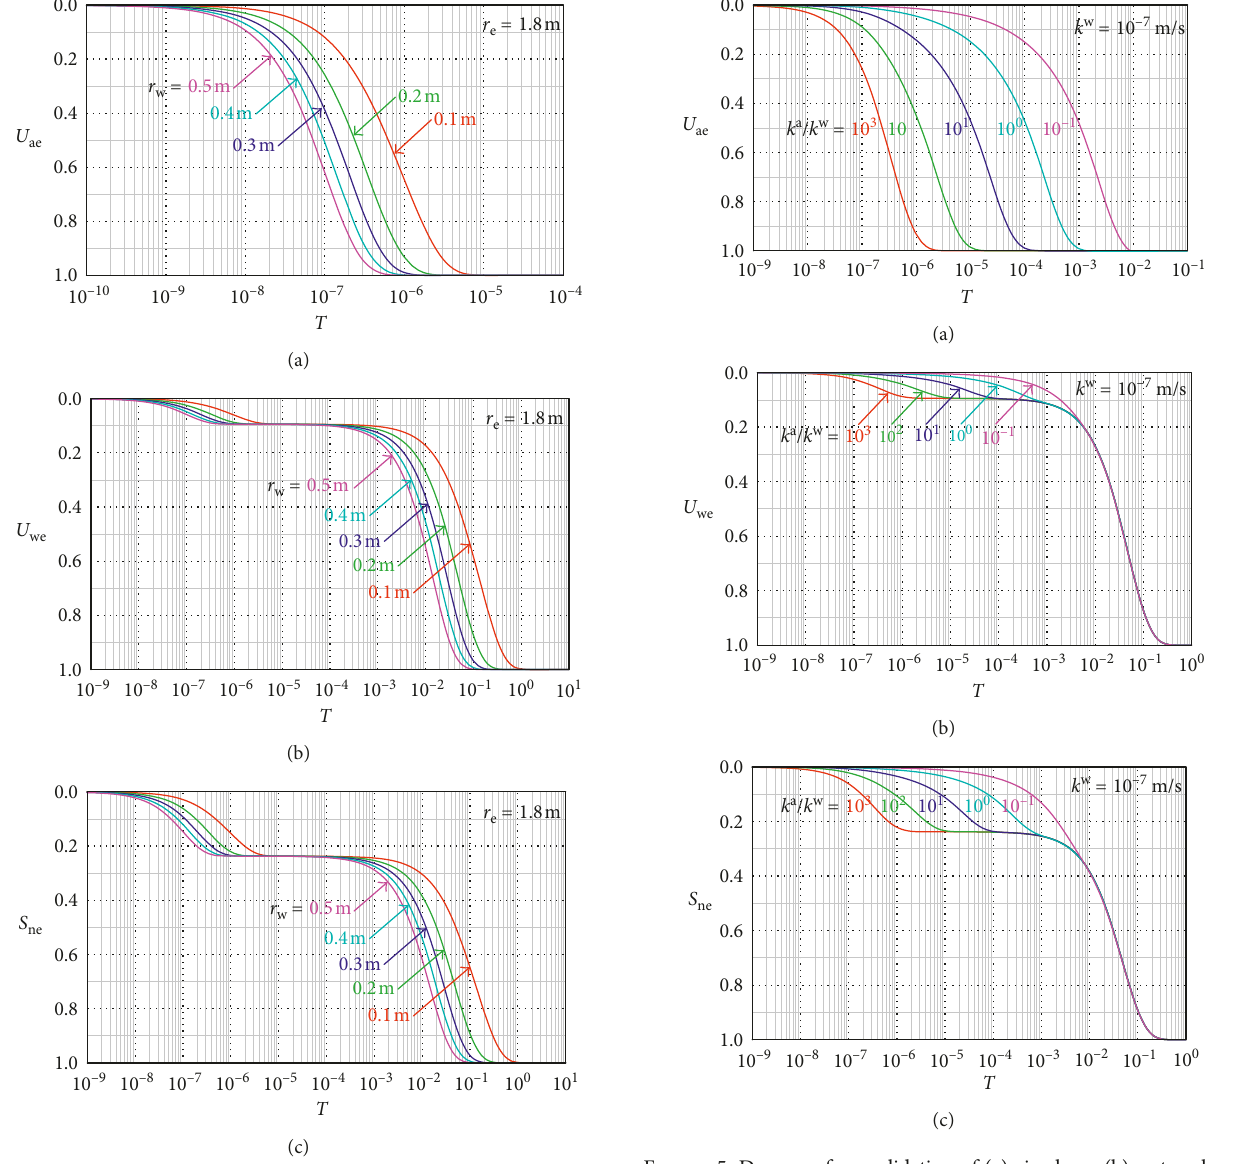
Figure 5: Degrees of consolidation of (a) air phase, (b) water phase, and (c) normalized settlement varying with different ratios of k a /k w . w